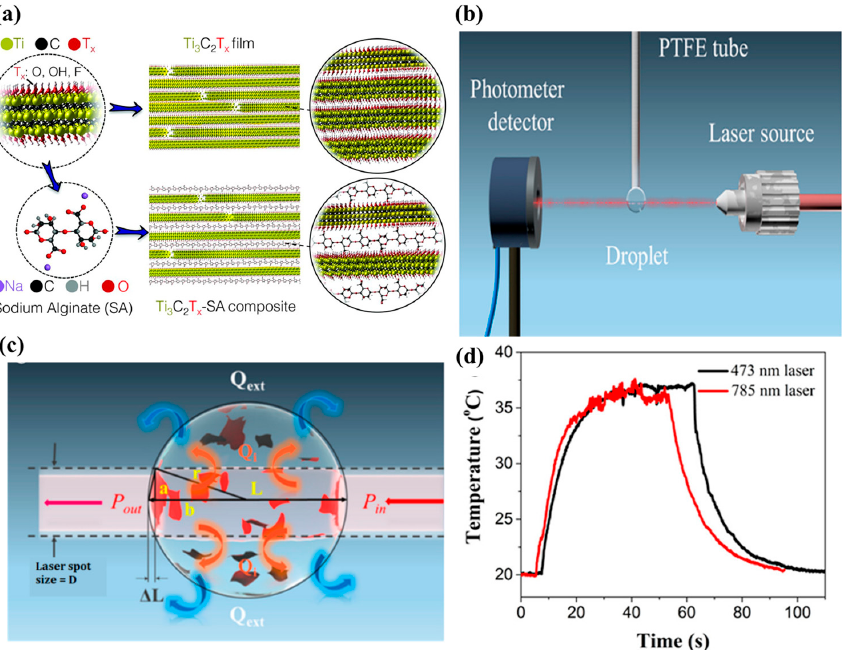
Figure 11. ( a ) Electromagnetic shielding interference mechanism of MXene [118]. ( b ) Experimental arrangement for droplet-related light-to-heat conversion [119]. ( c ) Schematic illustration of the droplet mechanism with laser irradiation [119]. ( d ) Time course of temperature profile of the droplet containing 0.1 mg/mL MXene in the light-to-heat conversion experiment under two separate laser irradiations [119].